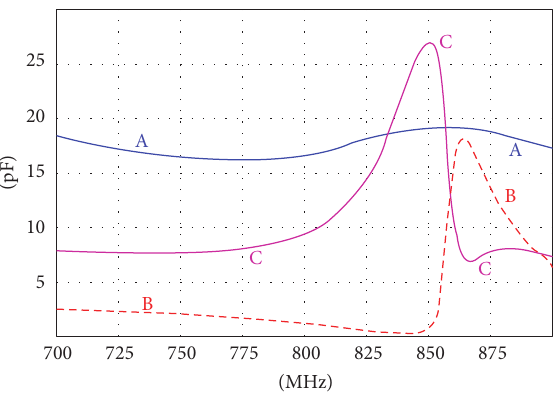
Figure 4: Capacitances of the adjustable impedance devices which realize C 𝐴 in the lossless MAPMUP antenna tuner: 𝐶 𝐴𝐺 is curve A; 𝐶 𝐶 𝐴𝑁 is curve B; and 𝐴𝐹 is curve C. Figure 5: Capacitances of the adjustable impedance devices which